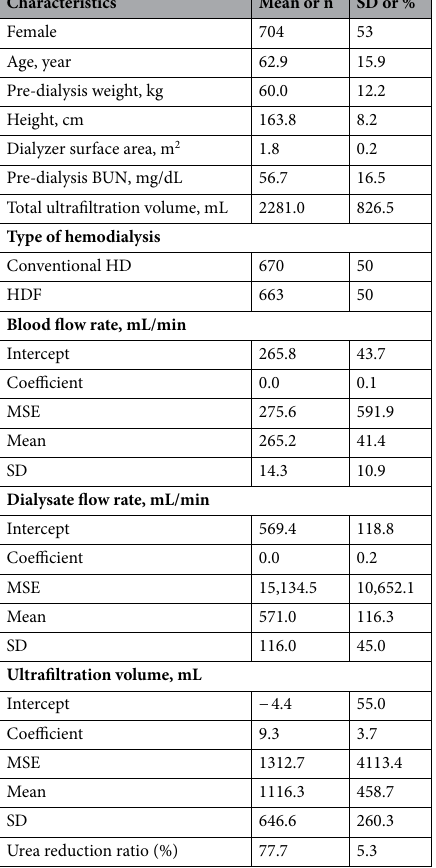
each model are depicted using scatter plots in Fig. 1. The results of other hyperparemeter settings are summa- rized in Supplementary Table S1.